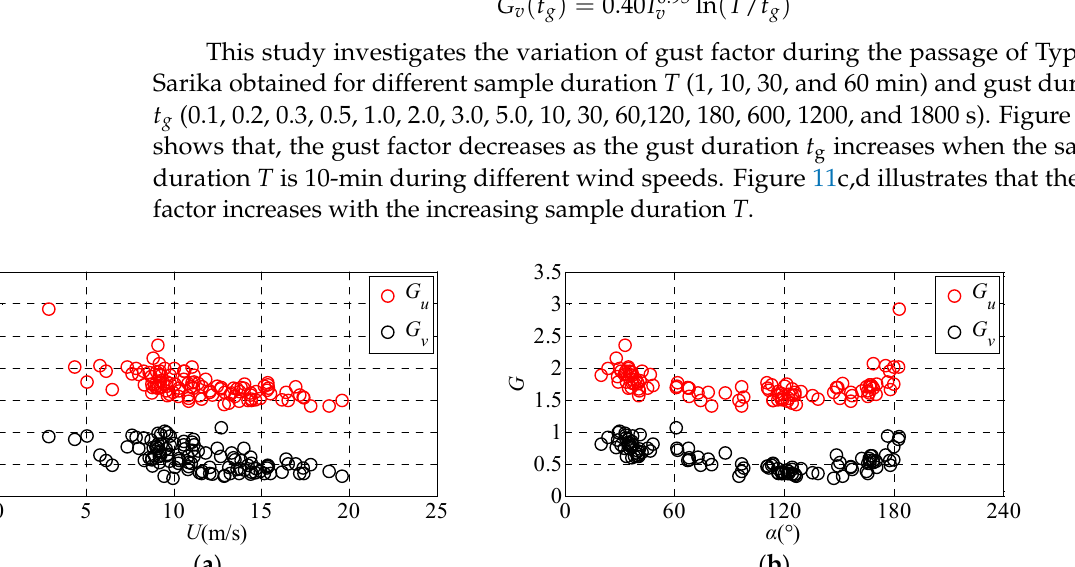
( b ) Figure 10. The relationship between gust factor and turbulence intensity. ( a ) Longitudinal gust fac- tors; ( b ) Lateral gust factors. ( a ) ( b )